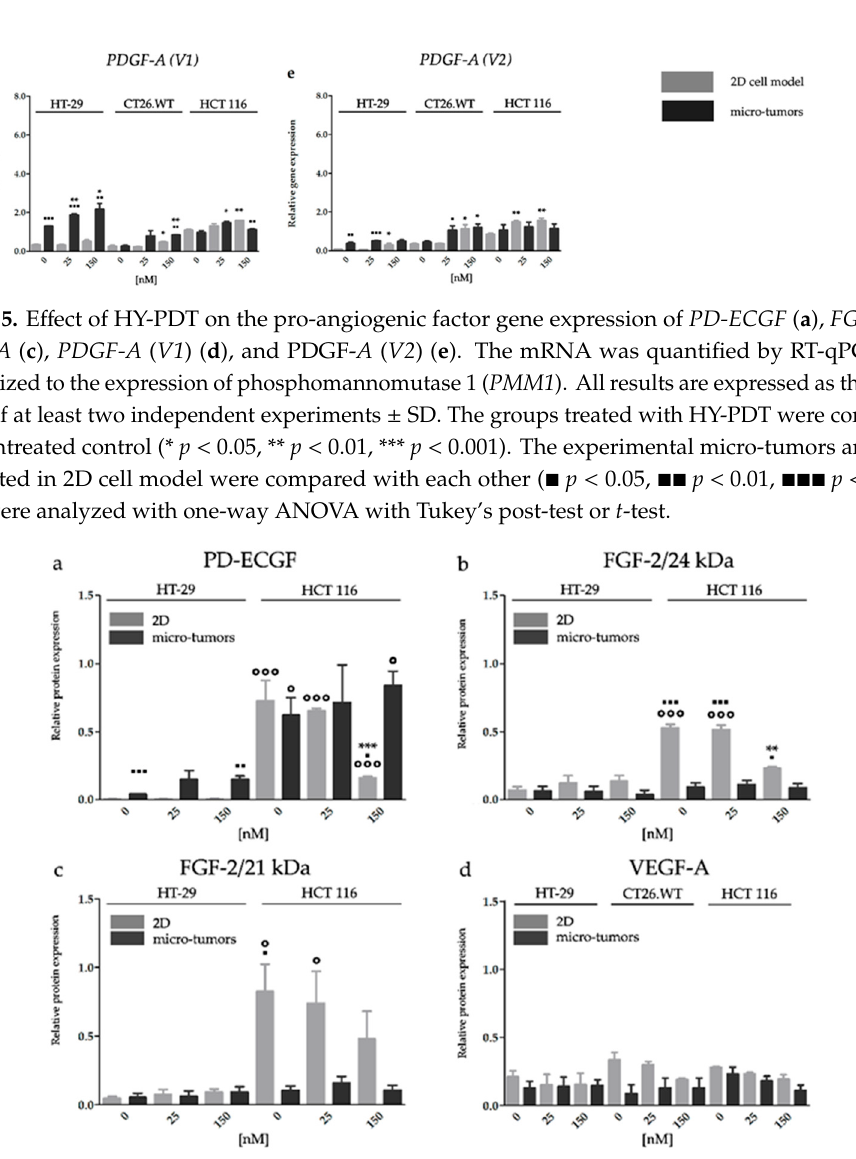
Figure 6. E ff ect of HY-PDT on the pro-angiogenic factors protein expression of PD-ECGF ( a ), FGF-2 / 24 kDa ( b ), FGF-2 / 21 kDa ( c ), and VEGF-A ( d ). Micro tumors are more resistant to HY-PDT than 2D cell models. The proteins were analyzed by Western blot. The e ff ect of HY-PDT on PD-ECGF, FGF-2, and VEGF-A expression in cells cultivated in 2D and micro-tumor cell model was analyzed 24 h after PDT. β -actin served as a loading control. The groups treated with HY-PDT were compared with untreated control (** p < 0.01, *** p < 0.001). The experimental micro-tumors and cells cultivated in 2D cell models were compared with each other ( ▪ p < 0.05, ▪▪▪ p < 0.001), so were the particular cell lines ( ₀ p < 0.05, ₀₀ p < 0.01, ₀₀₀ p < 0.001). Data were analyzed with one-way ANOVA with Tukey´s post-test or t -test.